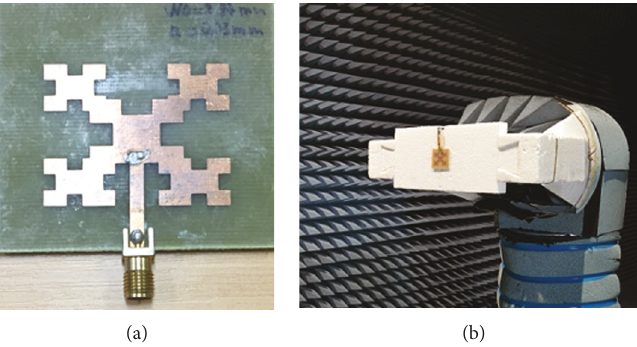
Figure 5: Photographs of the proposed antenna alone (a) and in an anechoic chamber measurement setup (b). Table 1: Comparison of resonance frequency, bandwidth, and radiation e ffi ciency simulation results. Resonance frequency (GHz) Bandwidth (%) Radiation e ffi ciency